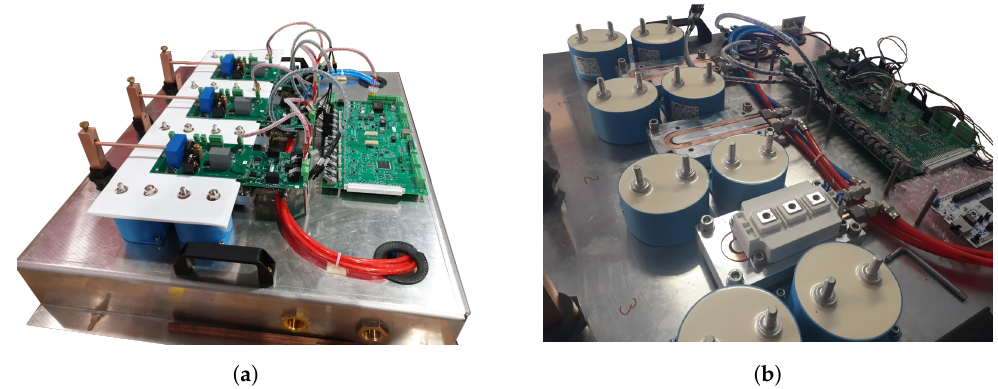
Figure 9. ( a ) Three-phase SiC converter prototype. ( b ) Cooling and power-module converter details.